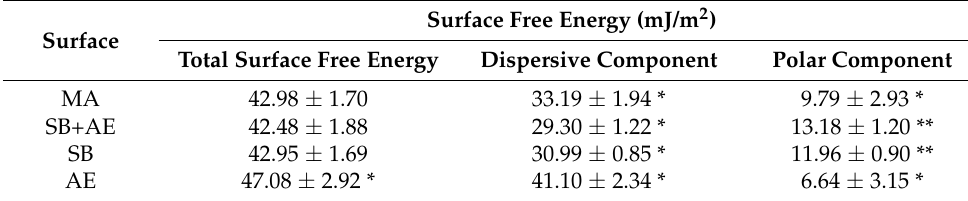
Table 3. Water contact angle, surface free energy and its components for the different Ti surfaces. Values are mean ± standard error of the mean. Statistical differences vs. smooth surfaces for each column are indicated by single and double asterisk symbols ( p <